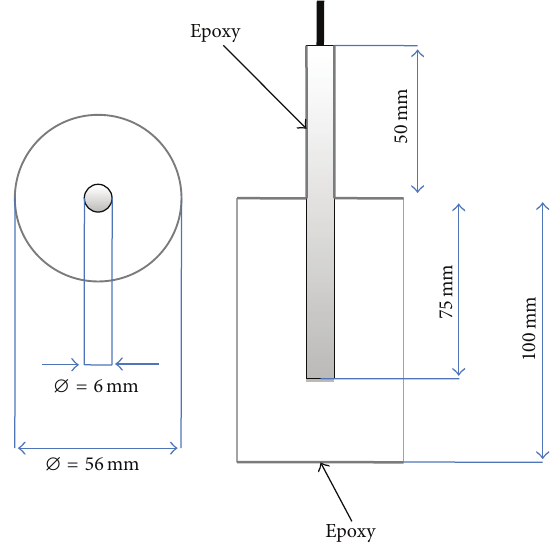
Figure 1: Diagram of the steel reinforced mortar samples: cover thickness = 25 mm; steel bar diameter = 6